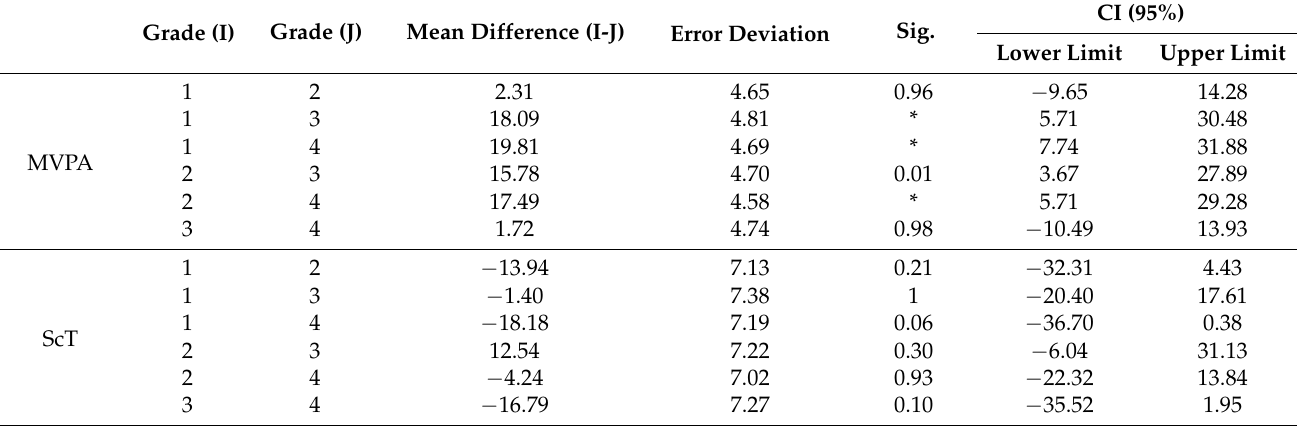
Table 4. Post-hoc multiple comparisons of